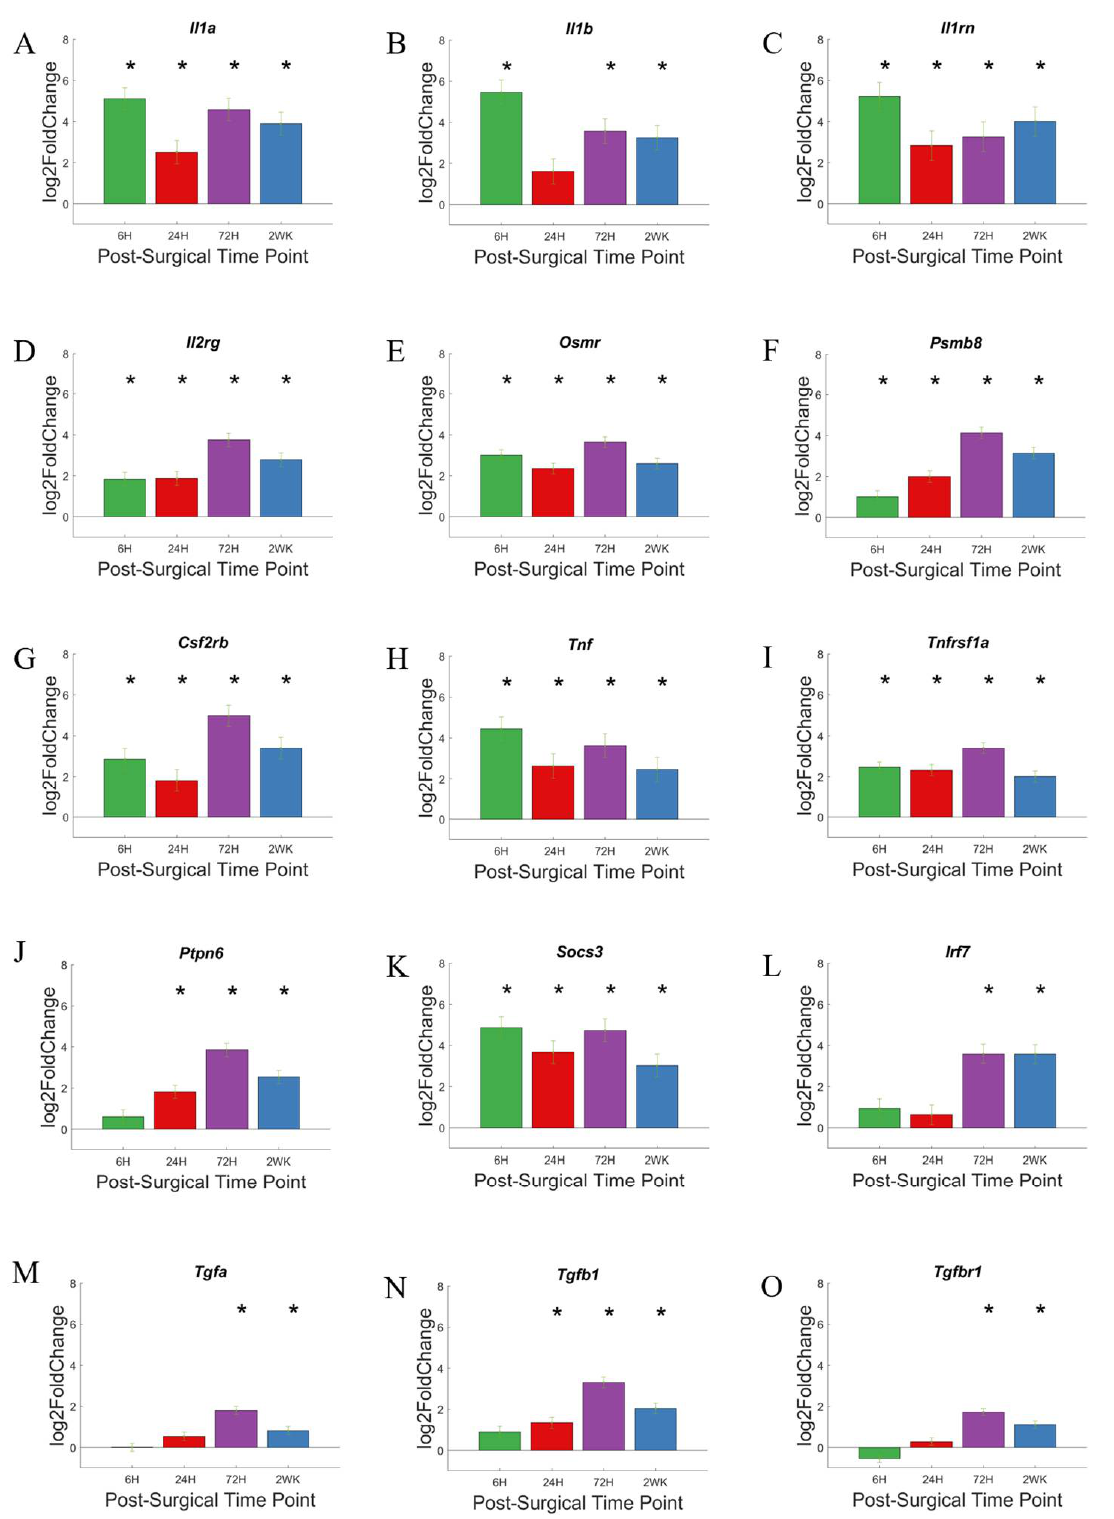
Figure 10. Differential expression of specific genes involved in the cytokine pathway compared to NSCTR mice: ( A – L ) Top differentially expressed genes for the cytokine gene set displayed as bar graphs of individual genes as a function of time post-surgery. For each time point, gene expression levels are compared to the NSCTR mice. ( M – O ) bar graph for TGF signaling pathways, which may be important for wound healing deemed important in the cytokine pathway. Error bars indicate the standard error of the mean between NSCTR and each time point. Asterisks indicate that P adj <